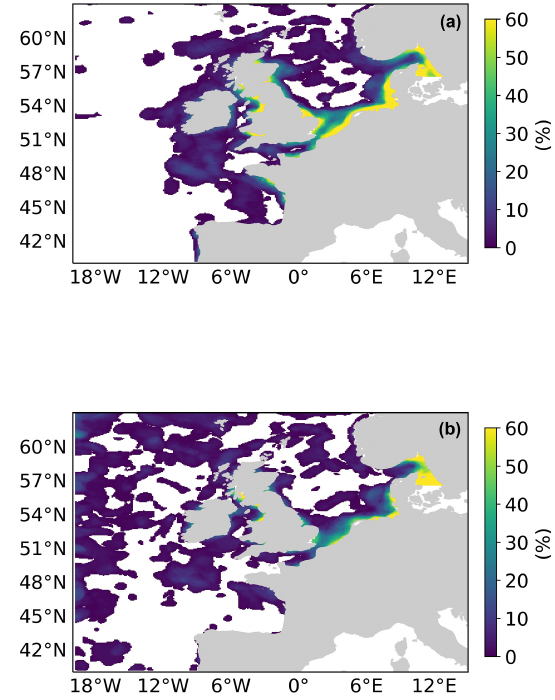
Figure 9. Object composites (the proportion of time for which an object was present at the grid box throughout the 2019 bloom season) for (a) the L4 ocean colour product objects and (b) the AMM7v11 analysis